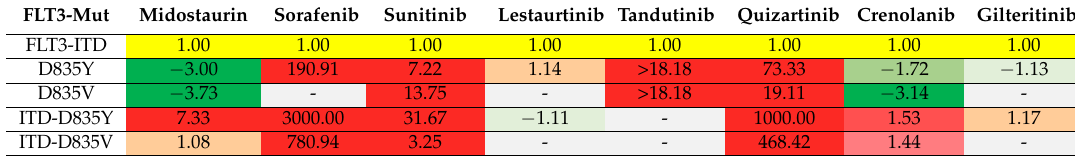
Table 2. Mutation-specific response to FLT3 inhibitors: Fold change in IC50 compared to FLT3-ITD. FLT3-Mut Midostaurin Sorafenib Sunitinib Lestaurtinib Tandutinib Quizartinib Crenolanib Gilteritinib FLT3-ITD 1.00 1.00 1.00 1.00 1.00 1.00 1.00 1.00 D835Y − 3.00 190.91 7.22 1.14 >18.18 73.33 − 1.72 − 1.13 D835V − 3.73 - 13.75 - >18.18 19.11 − 3.14 - ITD-D835Y 7.33 3000.00 31.67 − 1.11 - 1000.00 1.53 1.17 ITD-D835V 1.08 780.94 3.25 - - 468.42 1.44